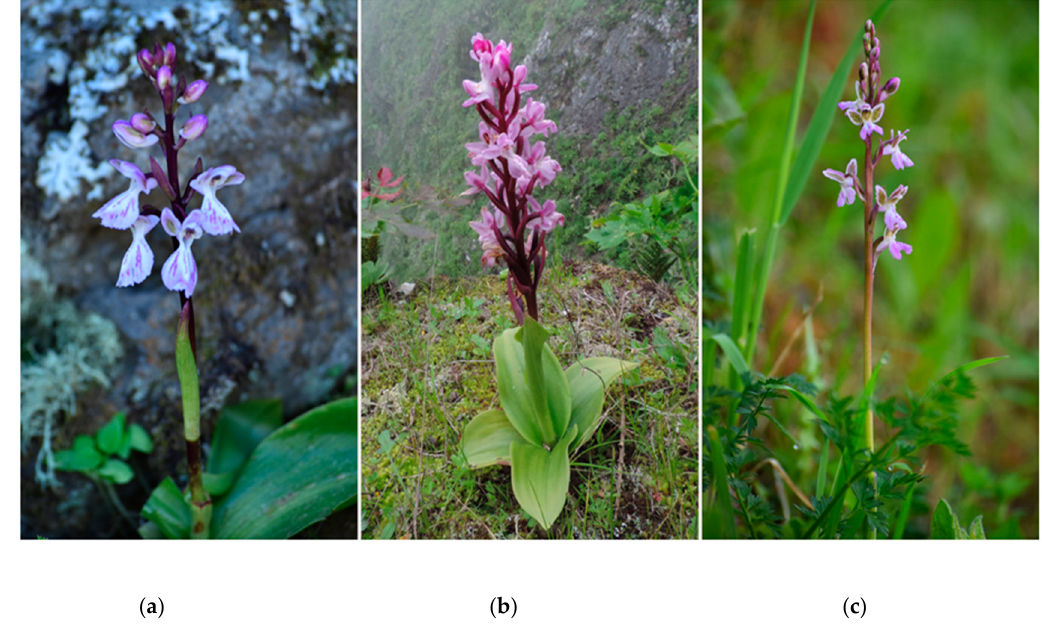
Figure 1. ( a ) Inflorescence of Orchis canariensis from Gran Canaria and ( b ) La Gomera (Canary Spain; ( c ) inflorescence of Orchis patens from Monticelli (Liguria), Islands), Spain; ( c ) inflorescence of Orchis patens from Monticelli (Liguria), Italy.